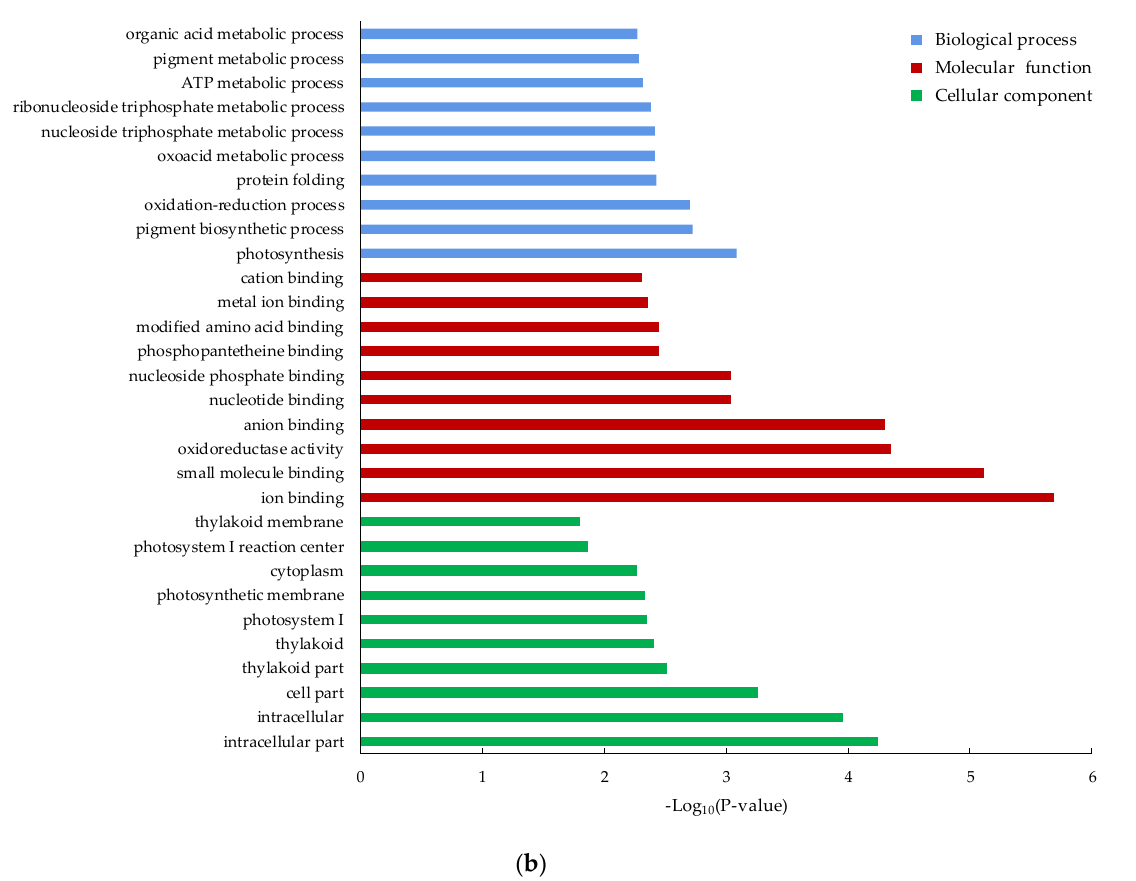
Figure 4. Gene ontology (GO) enrichment analysis of the differently expressed genes at two groups compared with CMA group. ( a ) MB2 vs. CMA comparison; ( b ) MB4 vs. CMA comparison. Table 2. Distribution of up- and down-regulated genes in KEGG